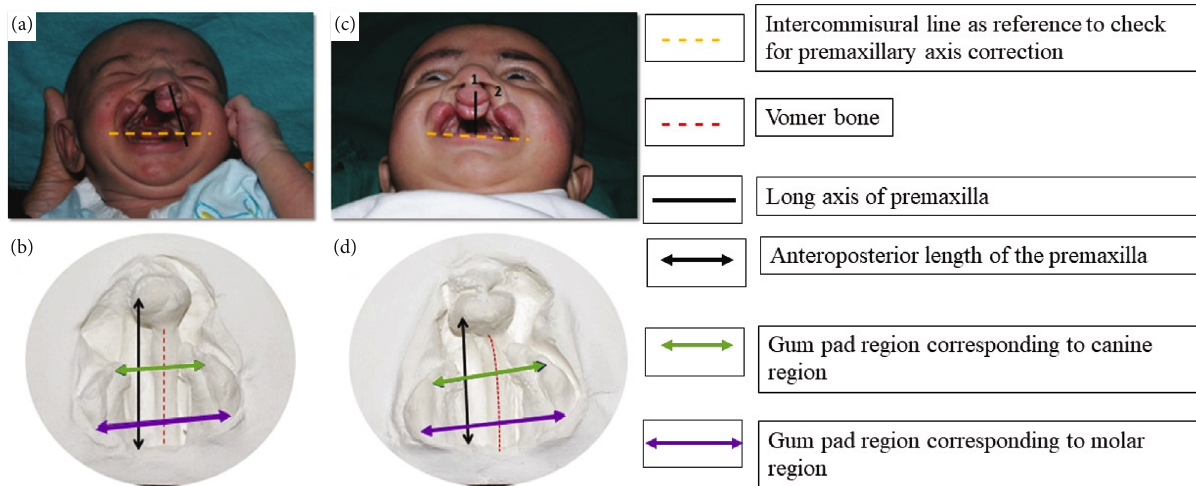
Figure 7: Comparison of pre- (a, b) and post-3D Versascrew appliance (c, d).